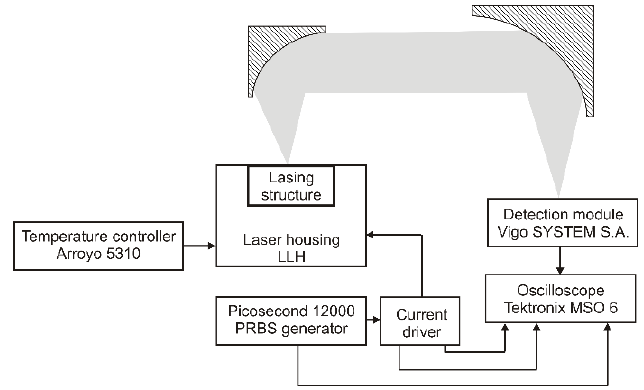
Figure 8. The schematic setup of the free space data link.